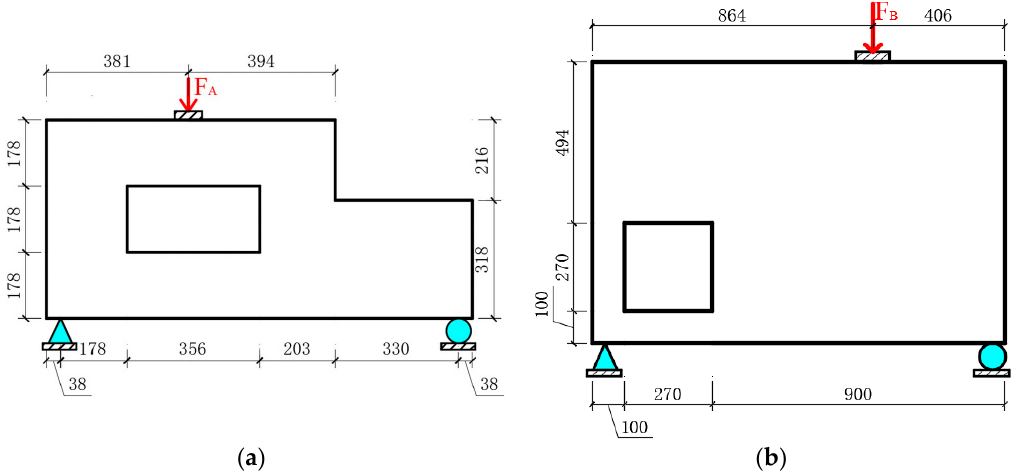
Figure 1. Geometry and dimensions of the irregular concrete deep beams: ( a ) Group A beam; ( b ) Group B beam (unit: mm).